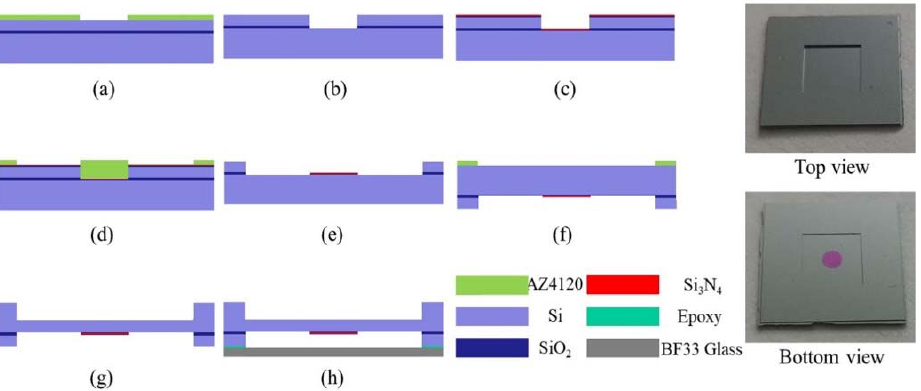
Figure 6. The fabrication process and photos of the fabricated pressure sensor: ( a ) Lithography; ( b ) DRIE (Deep Reactive Ion Etching); ( c ) Deposits SiO 2 and Si 3 N 4 ; ( d ) Lithography; ( e ) Wet etching; ( f ) Lithography; ( g ) DRIE (Deep Reactive Ion Etching); ( h ) Anodic bonding.